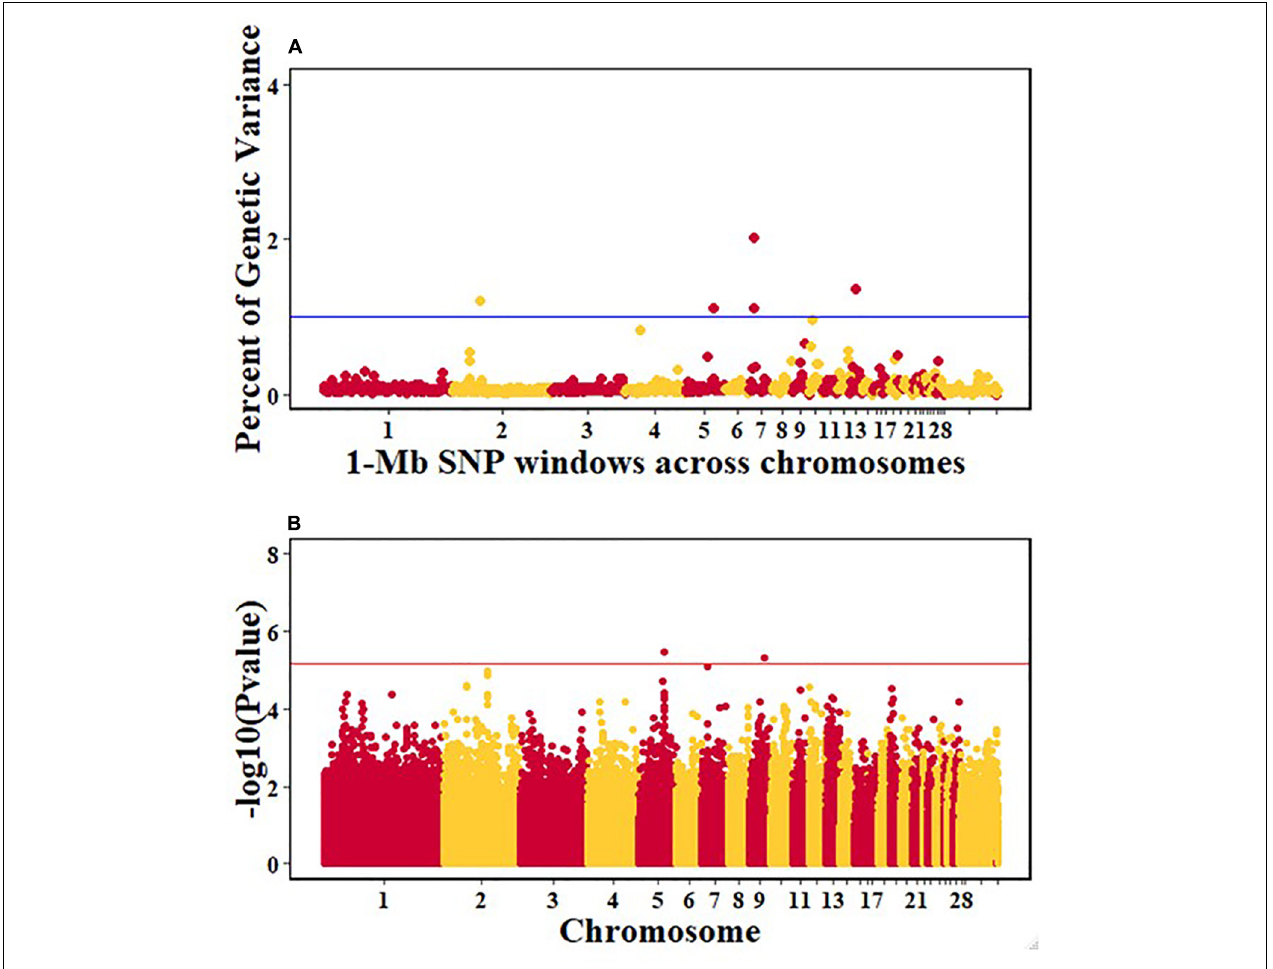
FIGURE 7 | Manhattan plots showing the genome-wide association results for viral load at 6 dpi in the Ghana local chicken ecotypes population, using Bayes-B and single-SNP analyses. (A) Bayes-B results showing the percent of genetic variance explained by SNPs in 1-Mb non-overlapping windows across chromosomes. (B) Single-SNP results showing the -log10(Pvalue) of ordered SNPs across the chromosomes. The blue and red lines indicate genome-wide significance at 1% genetic variance and 20% genome-wide suggestive association,